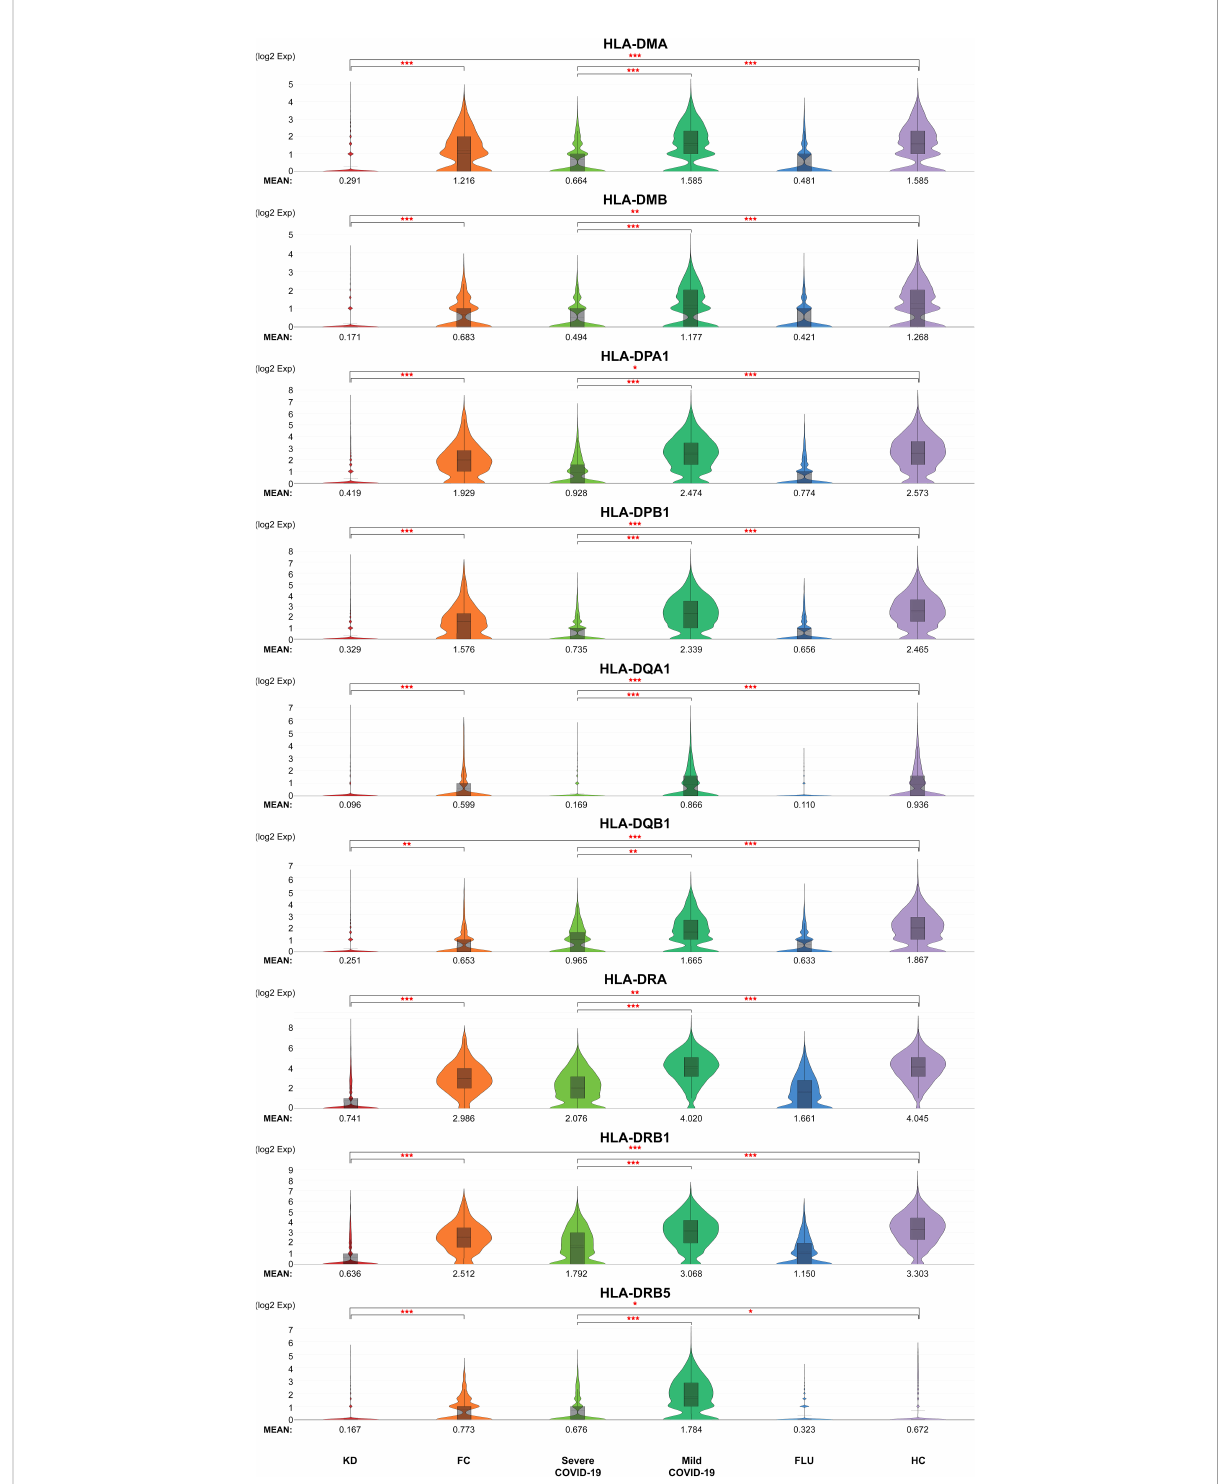
FIGURE 5 Generally reduced MHC class II in neutrophils of both KD and severe COVID-19 patients. Violin plots of normalized log2 expression levels of MHC class genes in cluster 2 identi fi ed in Figure 3A. The panel of genes was chosen based on their known role in antigen presentation and interferon- g -mediated signaling pathway. < 0.05 (*), < 0.005 (**) or < 0.0005